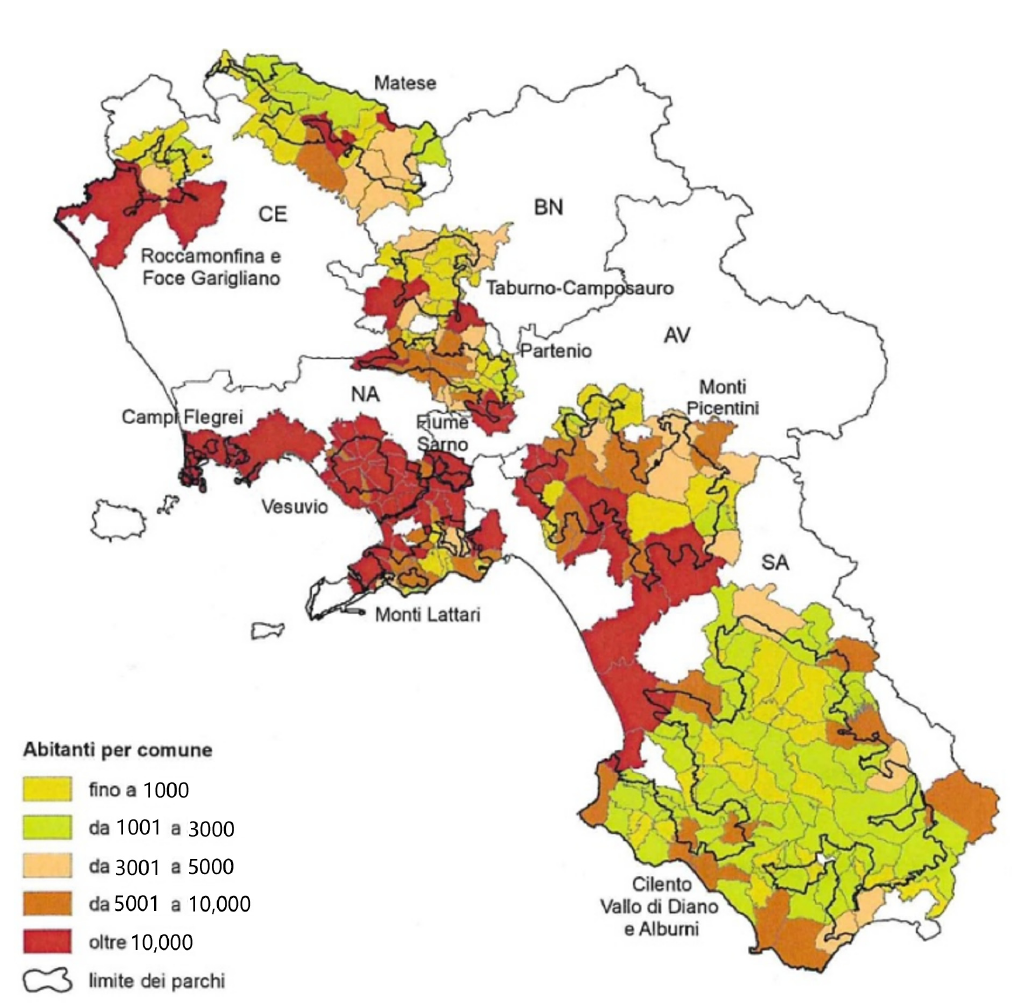
Figure 2. Campania Region. Parks with municipal territories and population. Keys: until 1000 in, yellow; by 1001 to 3000 (green); by 3001 to 5000, (brown); over 10,000 (red); with continuous black line, park area boundary [7].